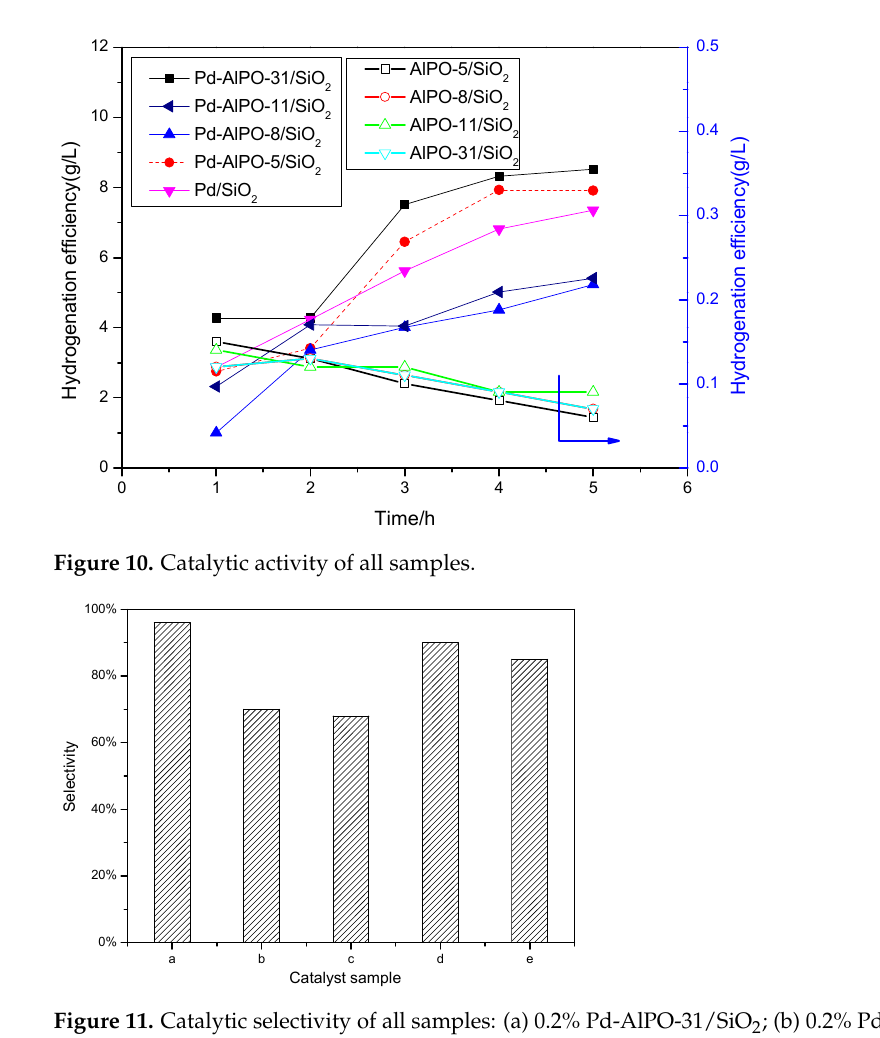
Figure 11. Catalytic selectivity of all samples: (a) 0.2% Pd-AlPO-31/SiO 2 ; (b) 0.2% Pd-AlPO-11/SiO 2 ; (c) 0.2% Pd-AlPO-8/SiO 2 ; (d) 0.2% Pd-AlPO-5/SiO 2 ; (e) 0.2% Pd/SiO 2 . According to Yu et al. [32], the adsorption of molecules such as oxygen, water, ben- zene, ammonia, carbon monoxide, pyridine and hydrazine causes the migration of Pd ions